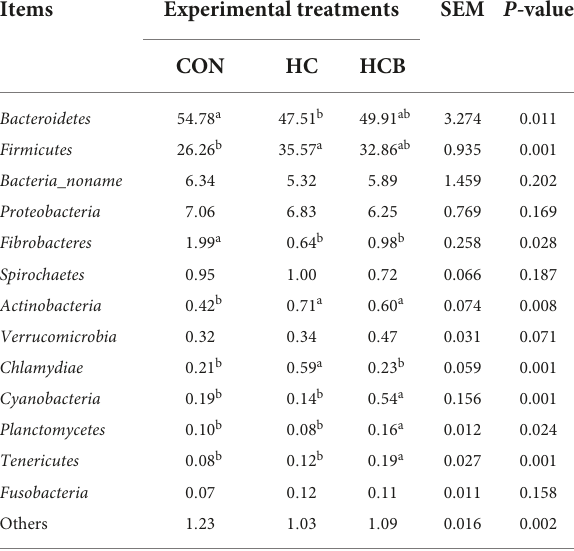
TABLE 5 Effect of high-concentrate diet feeding and thiamine supplementation on relative abundance of rumen bacteria (%, level of phyla, n = 6).